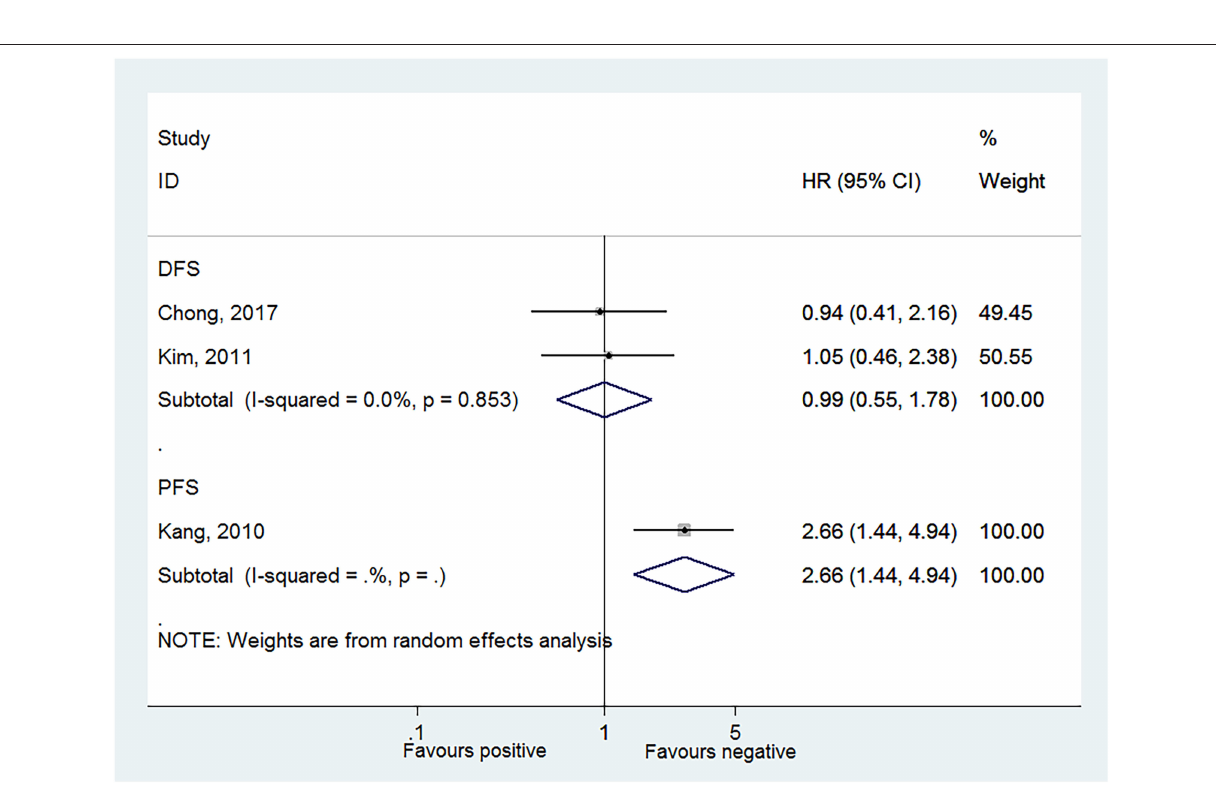
Frontiers in Oncology |